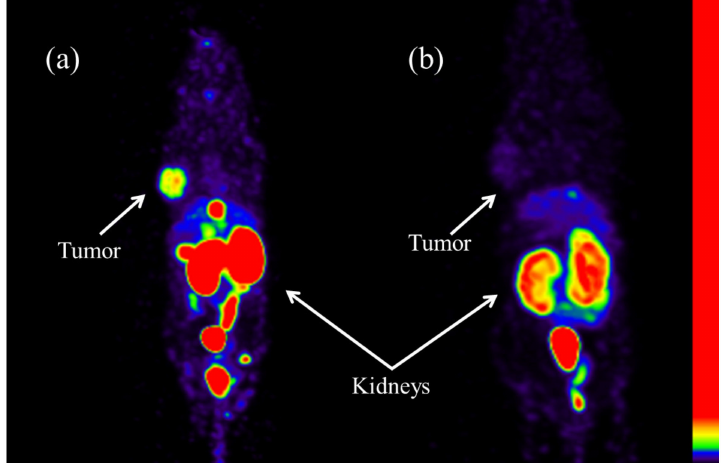
Figure 3. SPECT imaging of [ 99m Tc]Tc-CNGU in PSMA + LNCaP tumor-bearing mice 1 h post-injection. ( a ) [ 99m Tc]Tc-CNGU. ( b ) Blockade by PSMA inhibitor ZJ-43 (500 µ